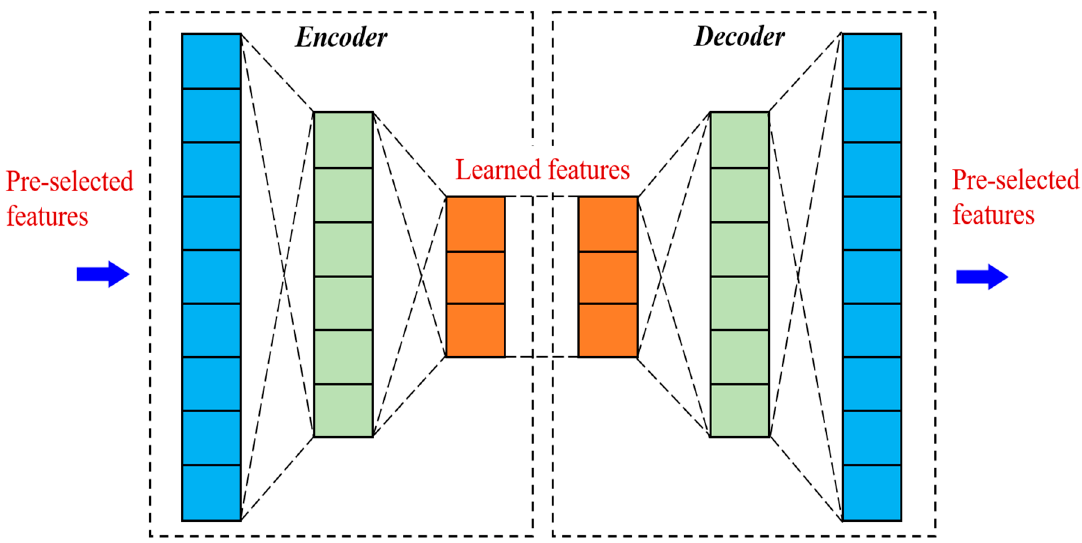
Figure 5. Symmetrical structure of deep autoencoder consisting of three-layer encoder and three-layer decoder.